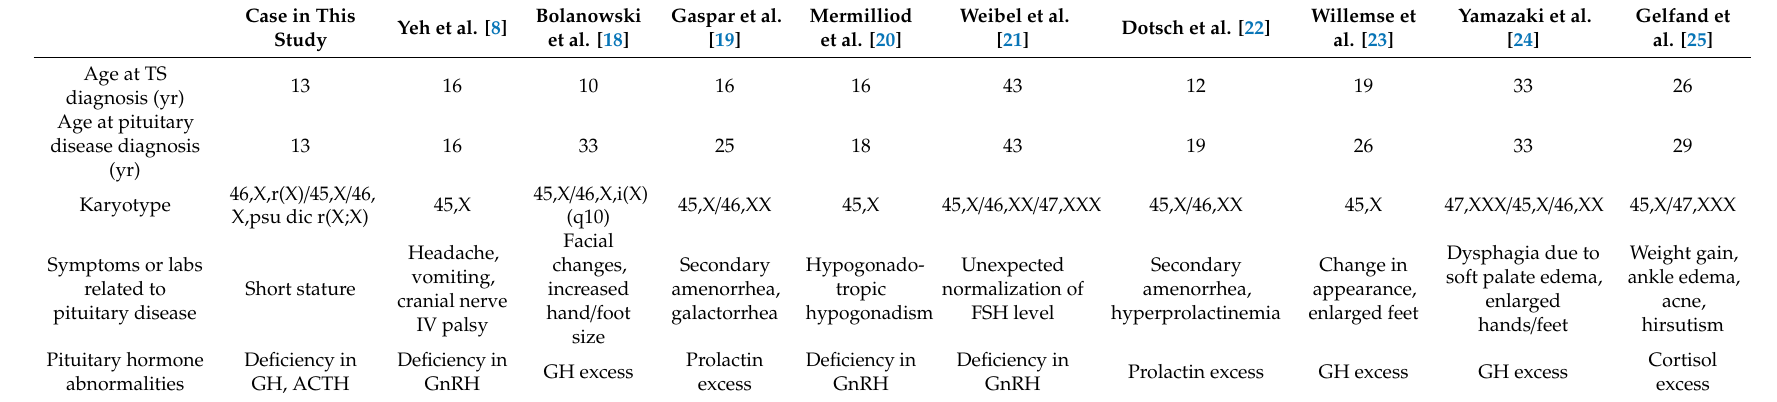
Table 2. Comparison of clinical and laboratory features between this case and previously reported cases of TS associated with pituitary